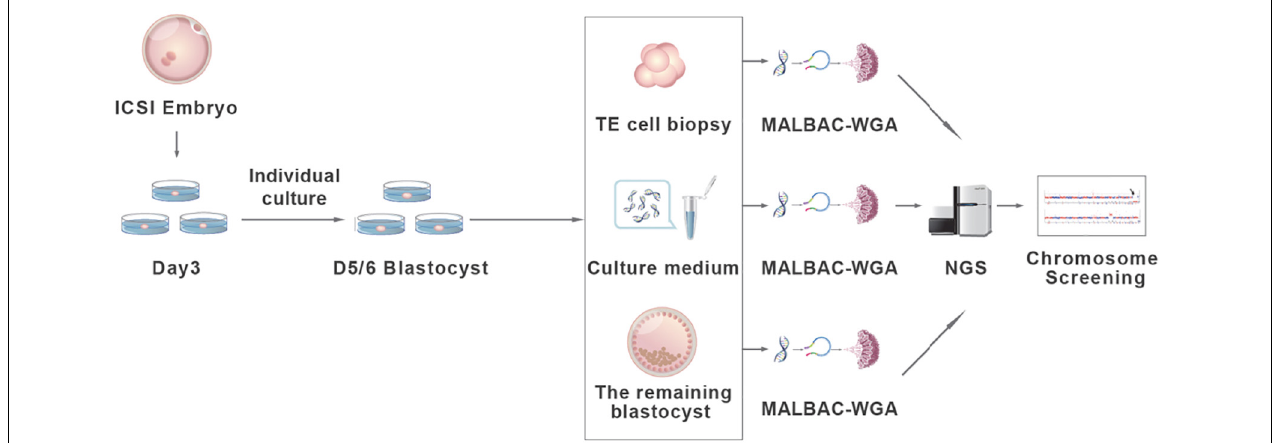
FIGURE 1 | The validation procedure of the non-invasive chromosome screening (NICS) assay. Briefly, D3 embryos achieved via intracytoplasmic sperm injection (ICSI) were individually cultured in blastocyst culture medium and grow to blastocysts. D5/6 blastocysts were morphologically evaluated according to Gardner score. Blastocysts ineligible for transfer were used for subsequent analysis. Three to five trophectoderm cells (TE cells), the spent culture medium, and the remaining whole embryos were collected separately and used for whole genome amplification (WGA) by multiple annealing and looping-based amplification cycles (MALBAC). Whole-genome–amplified products were sequenced using an Illumina HiSeq 2500 platform and the chromosome ploidy information was obtained from all three assays for